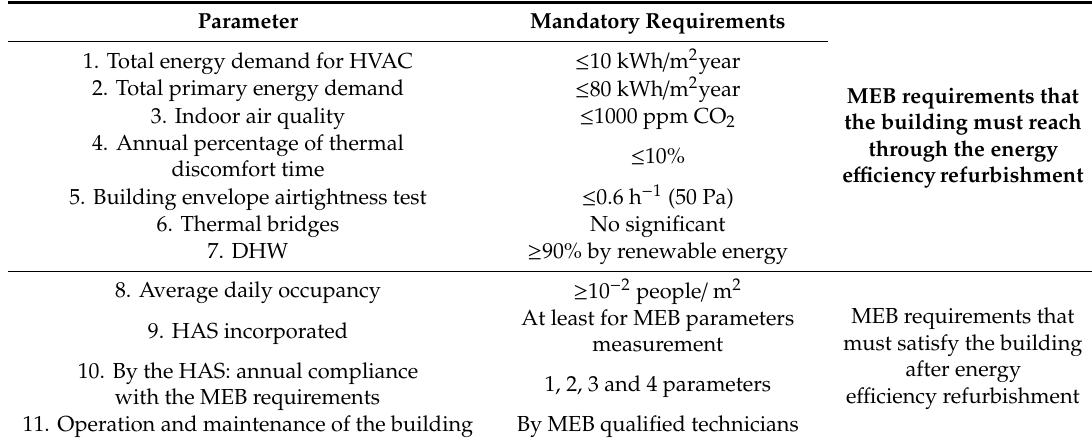
Table 1. Minimum energy buildings (MEB) mandatory